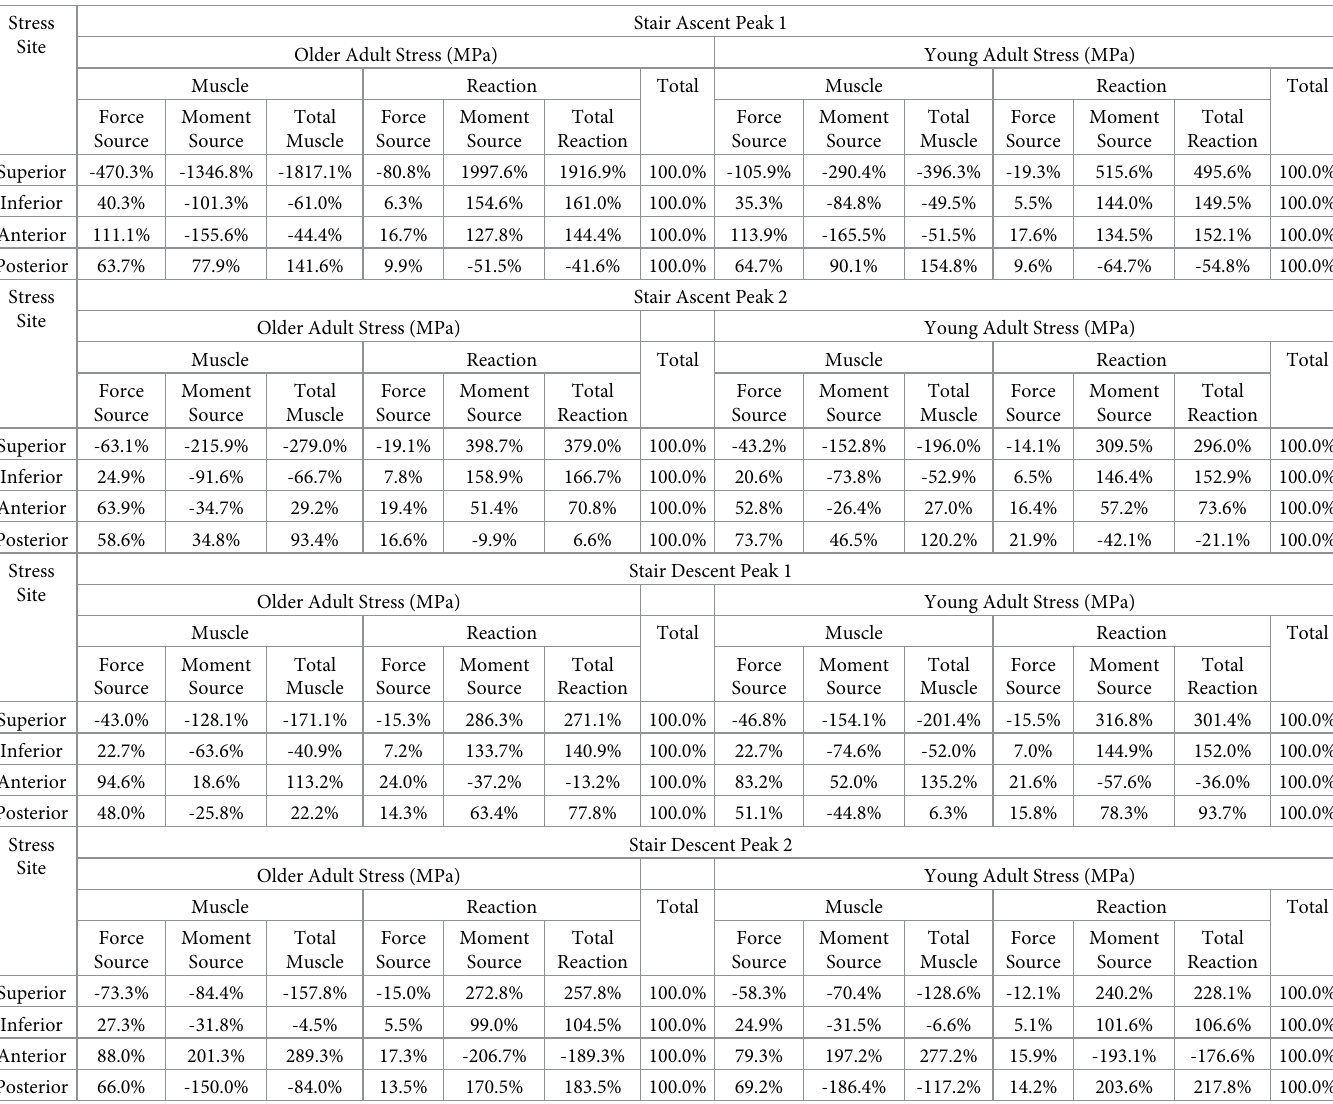
Table 3. The percentage of stress from each component in 4 sites of femoral neck during stair ascent and descent. Stress